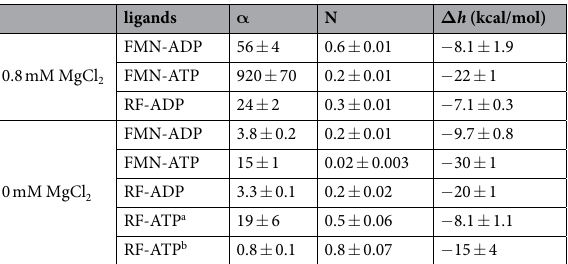
Table 3. Cooperativity coefficients ( α ) for the binding of different combinations of FLV and ANP ligands to the RFK module. Experiments were carried out at 25 °C in PIPES 20 mM and 0.8 mM MgCl 2 , pH 7.0, as well as in the same buffer without MgCl 2 . The variable α represents the cooperativity coefficient between each pair of ligands, N the fraction of total protein able to bind the titrating ligand, and Δ h the enthalpy change associated with each process. Errors were generally assumed to be larger than the standard deviation between replicates and the numerical error after fitting analysis. a Data from the titration at the maximum of cooperativity, 7.5 μ M RF. b Data from the titration at 180 μ M